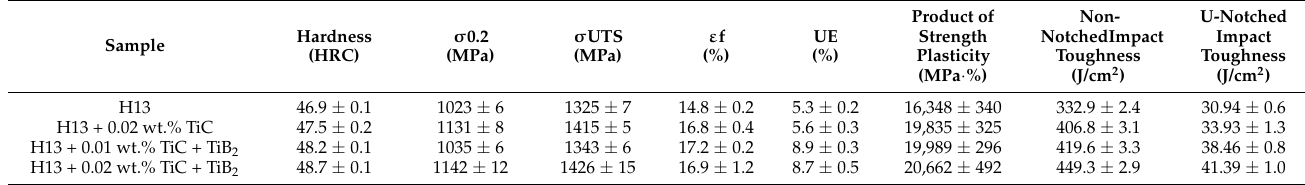
Table 2. Tensile properties and impact toughness of H13 steels without and with different contents of nanoparticles at room